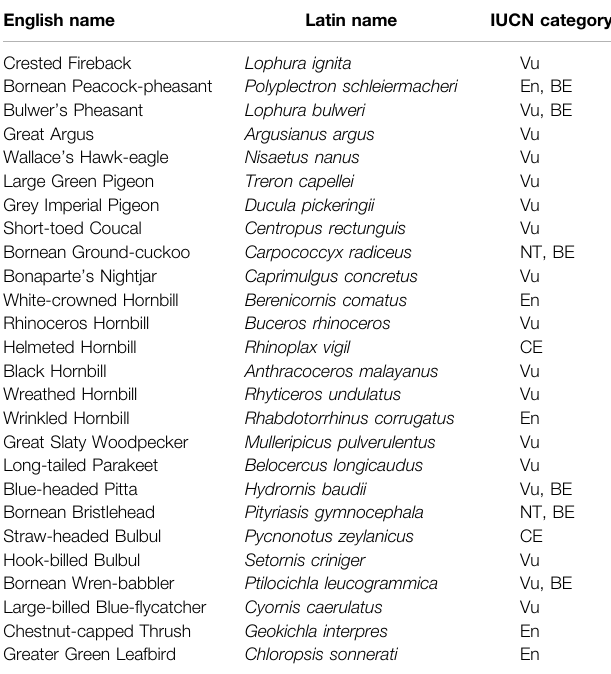
TABLE 1 | Species analyzed for presence in dawn chorus and autonomous recordings using pattern matching